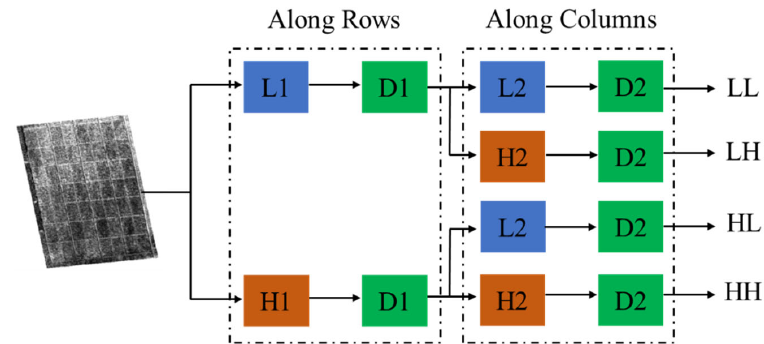
Figure 4. Decomposition procedure of the multi ‐ scale image. Note: L1 is the first low ‐ pass filter. L2 is the second low ‐ pass filter. H1 is the first high ‐ pass filter. H2 is the second high ‐ pass filter. D1 is the first downsampling. D2 is the second downsampling. LL is an approximate sub ‐ image. LH is a horizontal detail sub ‐ image. HL is a vertical detail sub ‐ image. HH is a diagonal detail sub ‐ image.